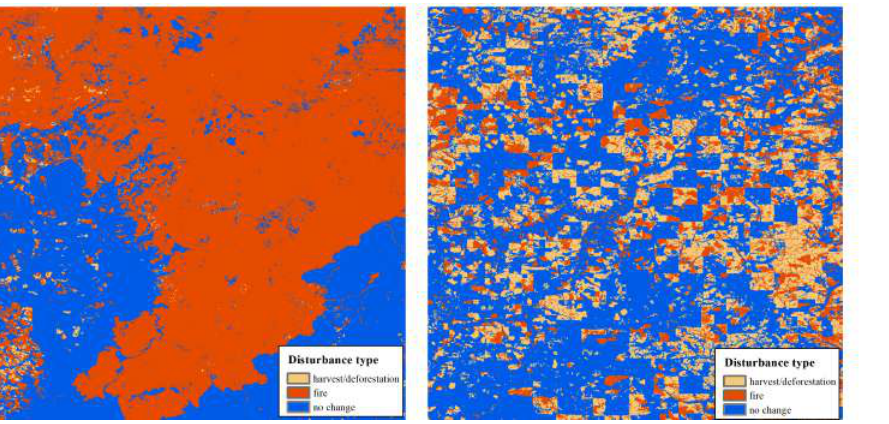
Figure 10. Disturbance type identification on area A and area B. Left area B is dominated by forest fire, while right area A is dominated by harvest/deforestation.